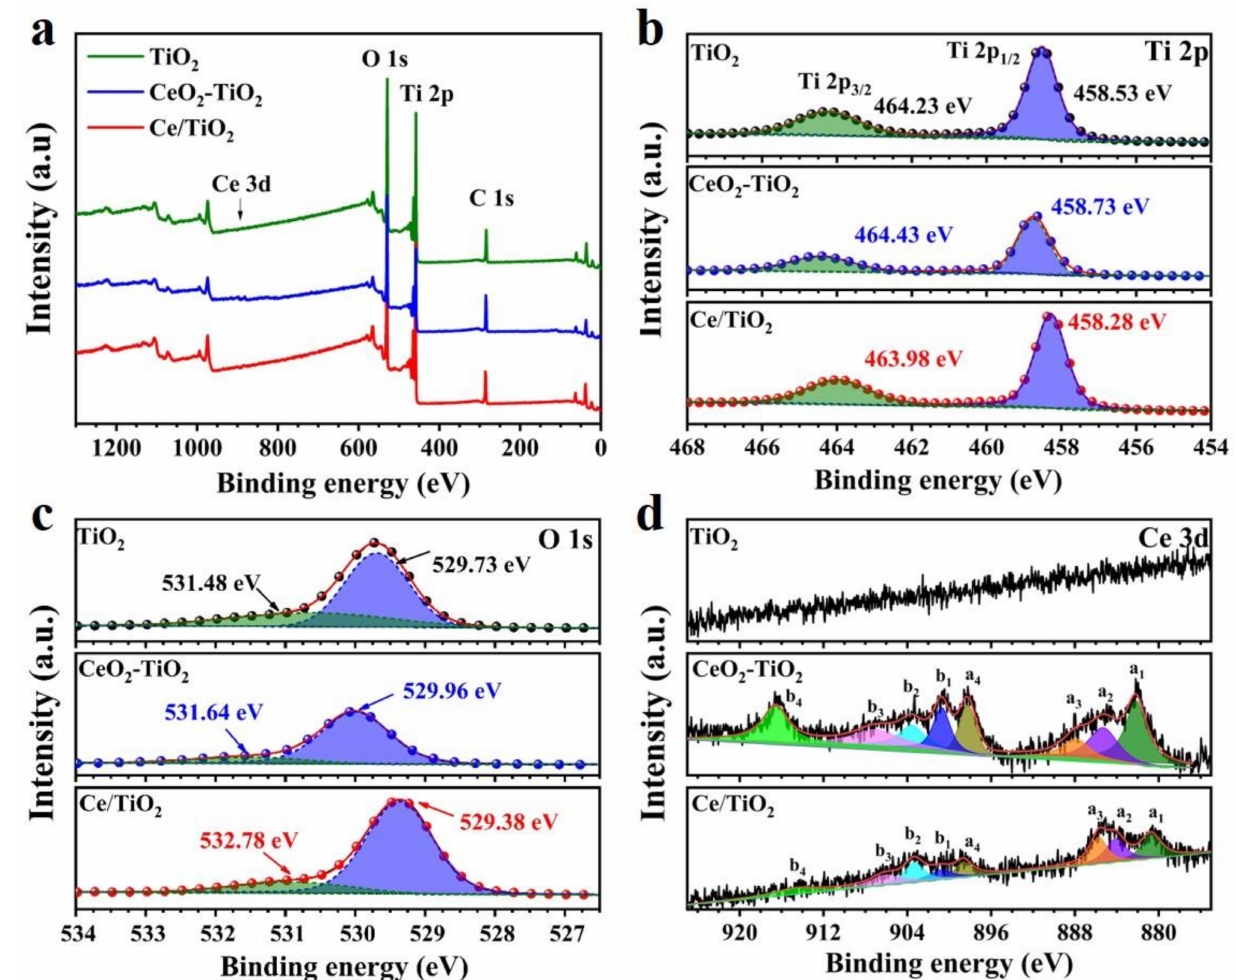
Figure 3. XPS spectra of the pure TiO 2 , Ce/TiO 2 , and CeO 2 -TiO 2 : ( a ) survey spectra; ( b ) Ti 2p; ( c ) O 1s; ( d ) Ce